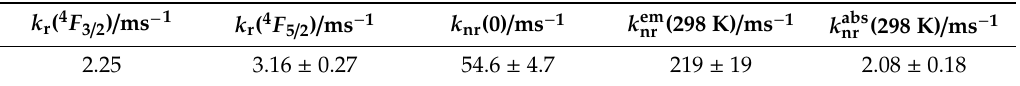
Table 2. Derived radiative and non-radiative rates characterizing the thermal coupling of the 4 F 3 / 2 and 4 F 3 + in microcrystalline La 5 / 2 spin-orbit levels of Nd 0.999 Nd 0.001 PO 4